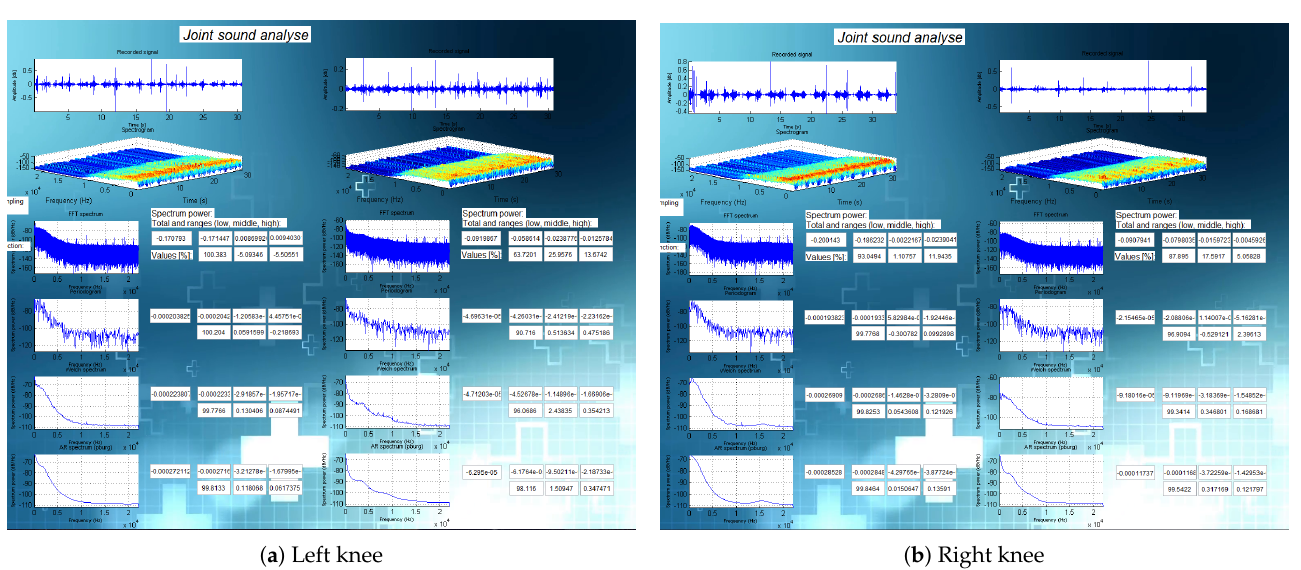
Figure A13. Analysis for subject